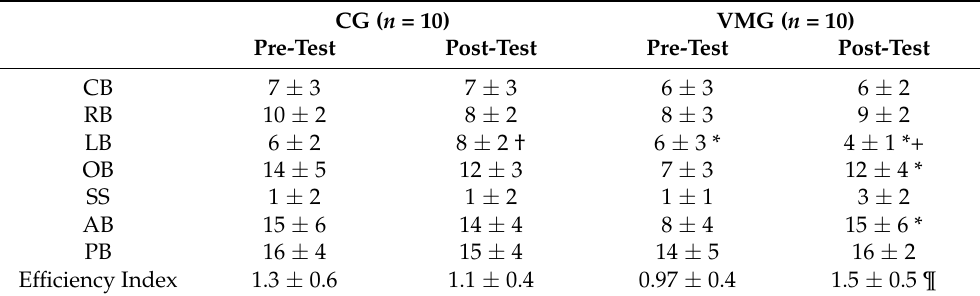
Table 5. Technical performances recorded in the small, sided games for both the video modeling group (VMG) and control group (CG) before and after the intervention period (Values are mean ± SD; n = 20).